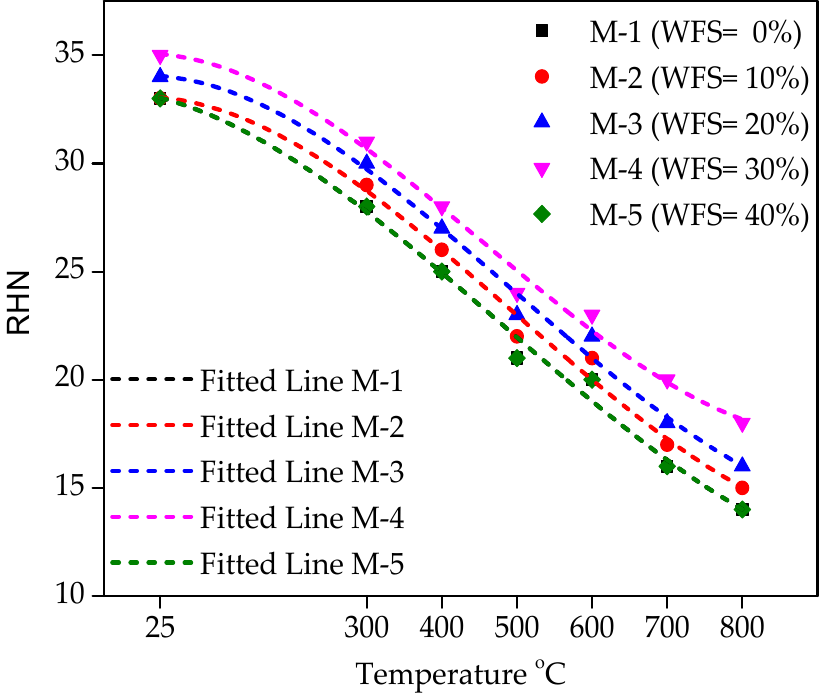
Figure 15. Relationship between the RHN under different temperature levels and WFS content.